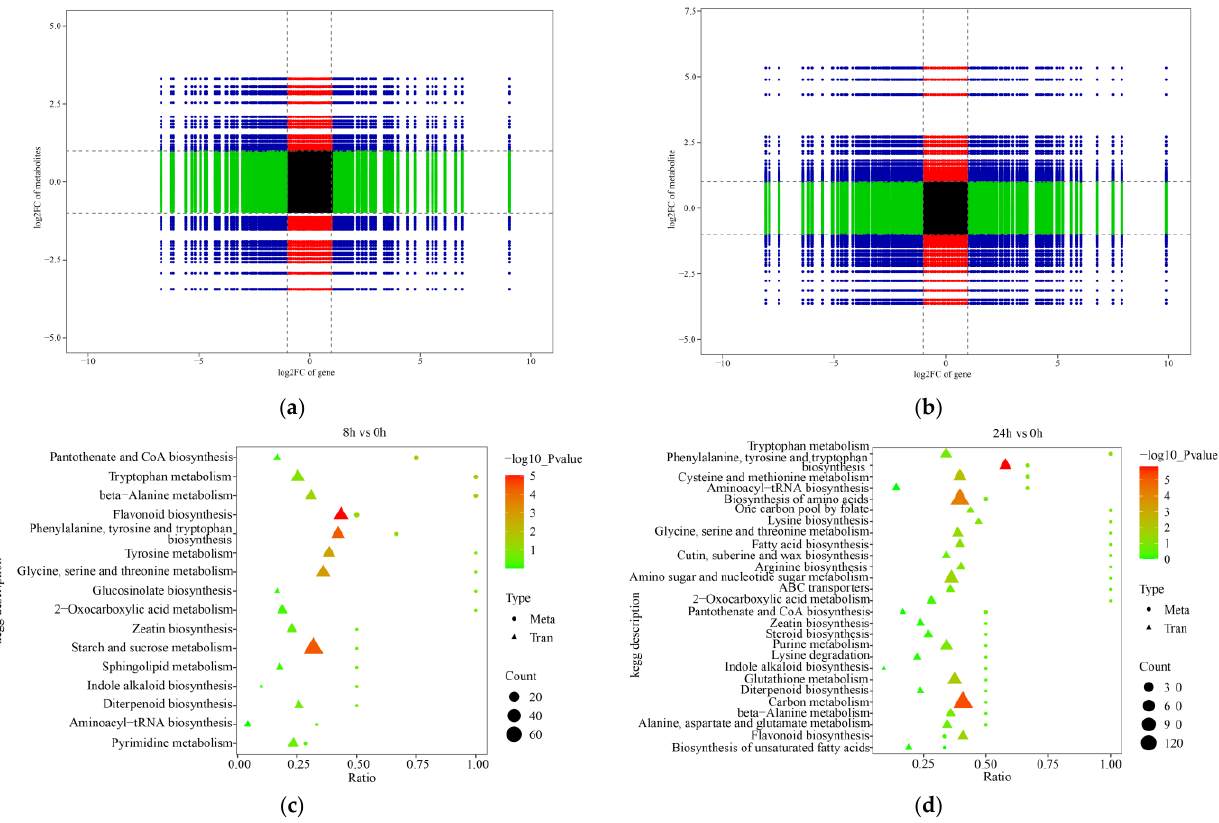
Figure 7. Correlation analysis and functional enrichment of differentially expressed genes (DEGs) and differentially expressed metabolites (DEMs). Nine-quadrant map of genes and metabolites in roots at 8 h vs. 0 h ( a ) and 24 h vs. 0 h ( b ). Association analysis of KEGG pathway with DEGs and DEMs in roots at 8 h vs. 0 h ( c ) and at 24 h vs. 0 h ( d ).